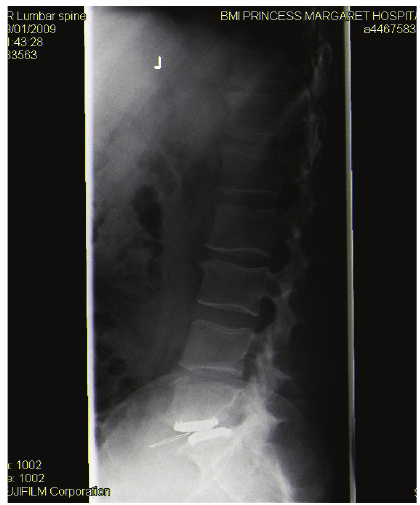
Figure 2: Plain radiograph showing a dislocated polyethylene inlay, but no pedicle fracture is